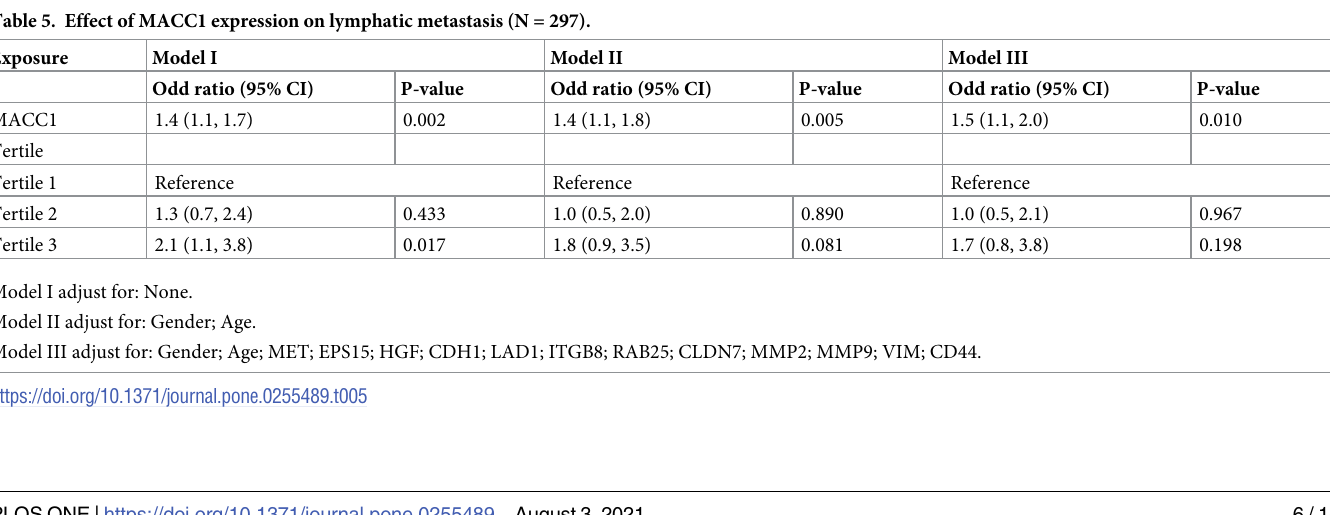
Model I adjust for: None.